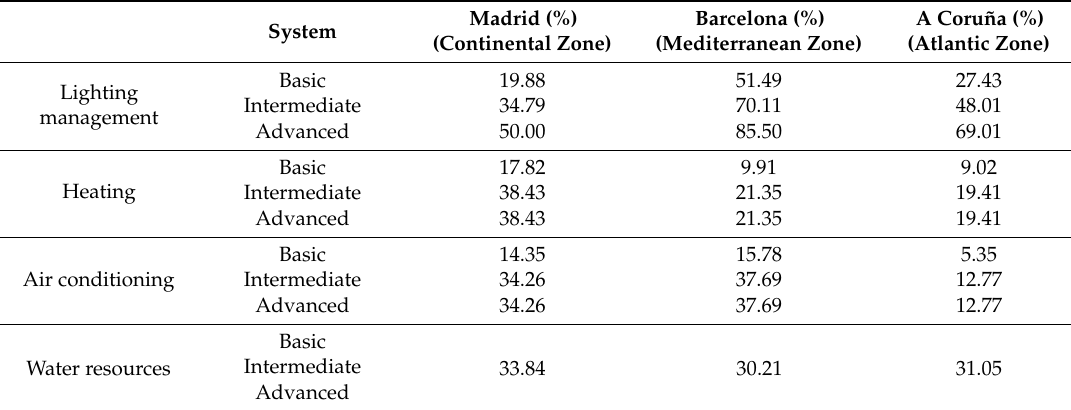
Table 18. Percentages of savings in lighting depending on its